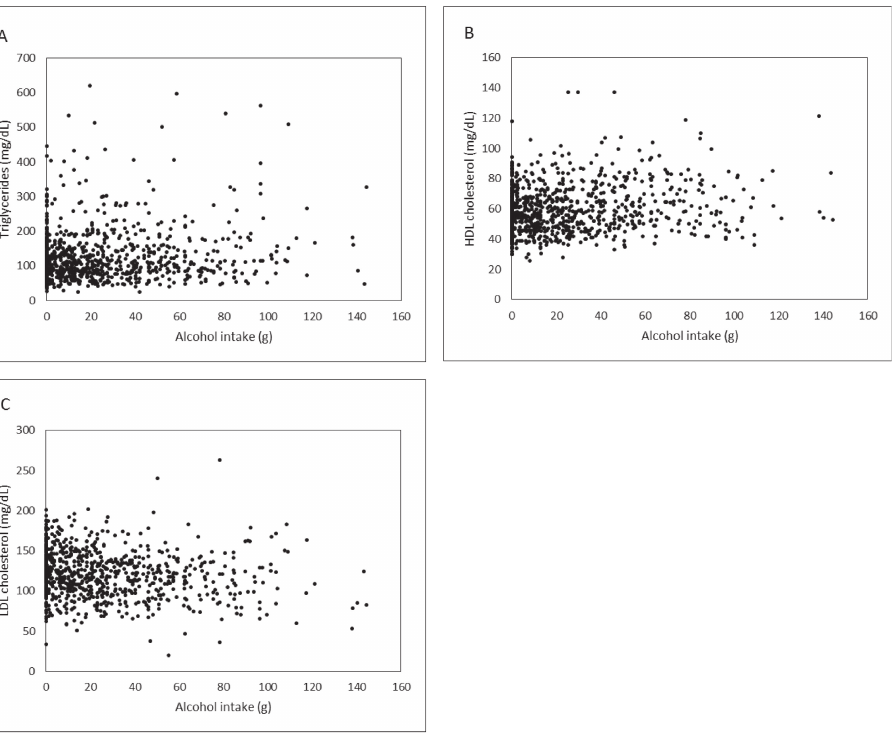
Figure 1. Scatter diagrams of alcohol intake and triglycerides (A), HDL cholesterol (B) and LDL cholesterol (C) in the main study. HDL, high-density lipoprotein; LDL, low-density lipoprotein.